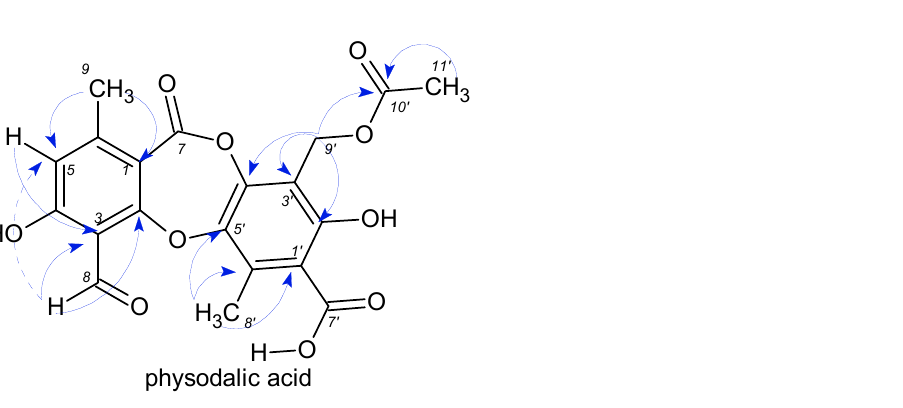
Figure 3. Chemical structure of depside physodalic acid along with its key HMBC correlations.